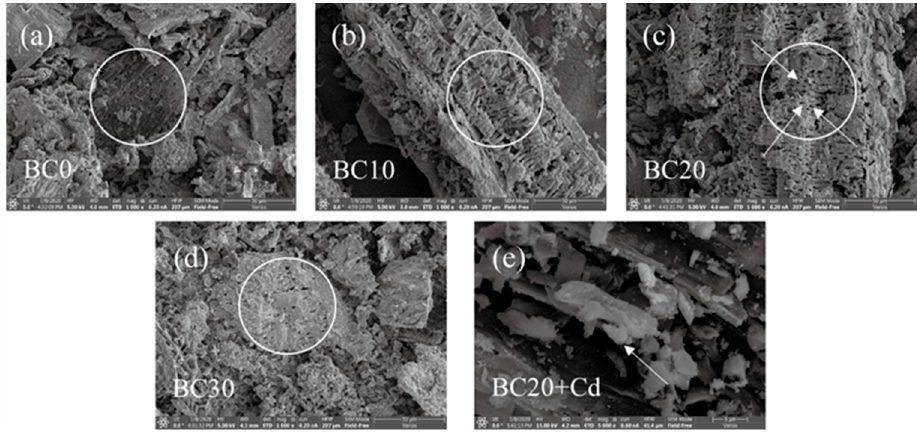
Figure 2. SEM images of ( a ) BC0, ( b ) BC10, ( c ) BC20, ( d ) BC30, and ( e ) BC20 after Cd 2+ adsorption.